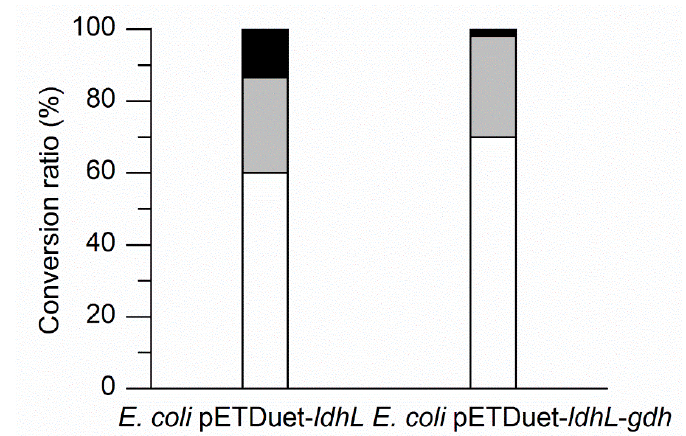
Figure 4. Comparison of batch biotransformation of L -PLA by E. coli pETDuet- ldhL and E. coli pETDuet- ldhL-gdh whole cells. White indicates L -PLA; black indicates residual PPA; and grey indicates PPA involved in other metabolic routes but PLA.